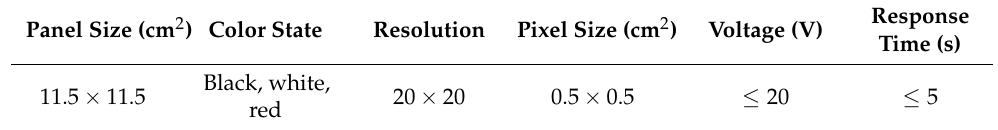
Table 1. Parameters of the three-color